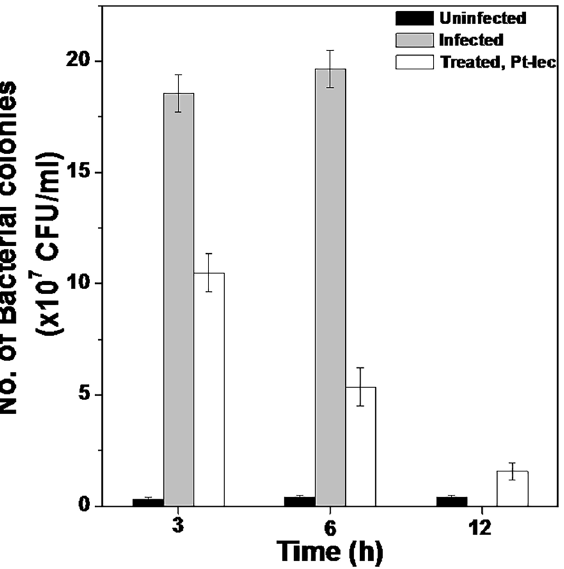
Figure 4. In vivo assay. The fishes treated with 1 × MIC Pt-lec showed declining number of viable cells with increasing time. At 12th h, infected fishes are not